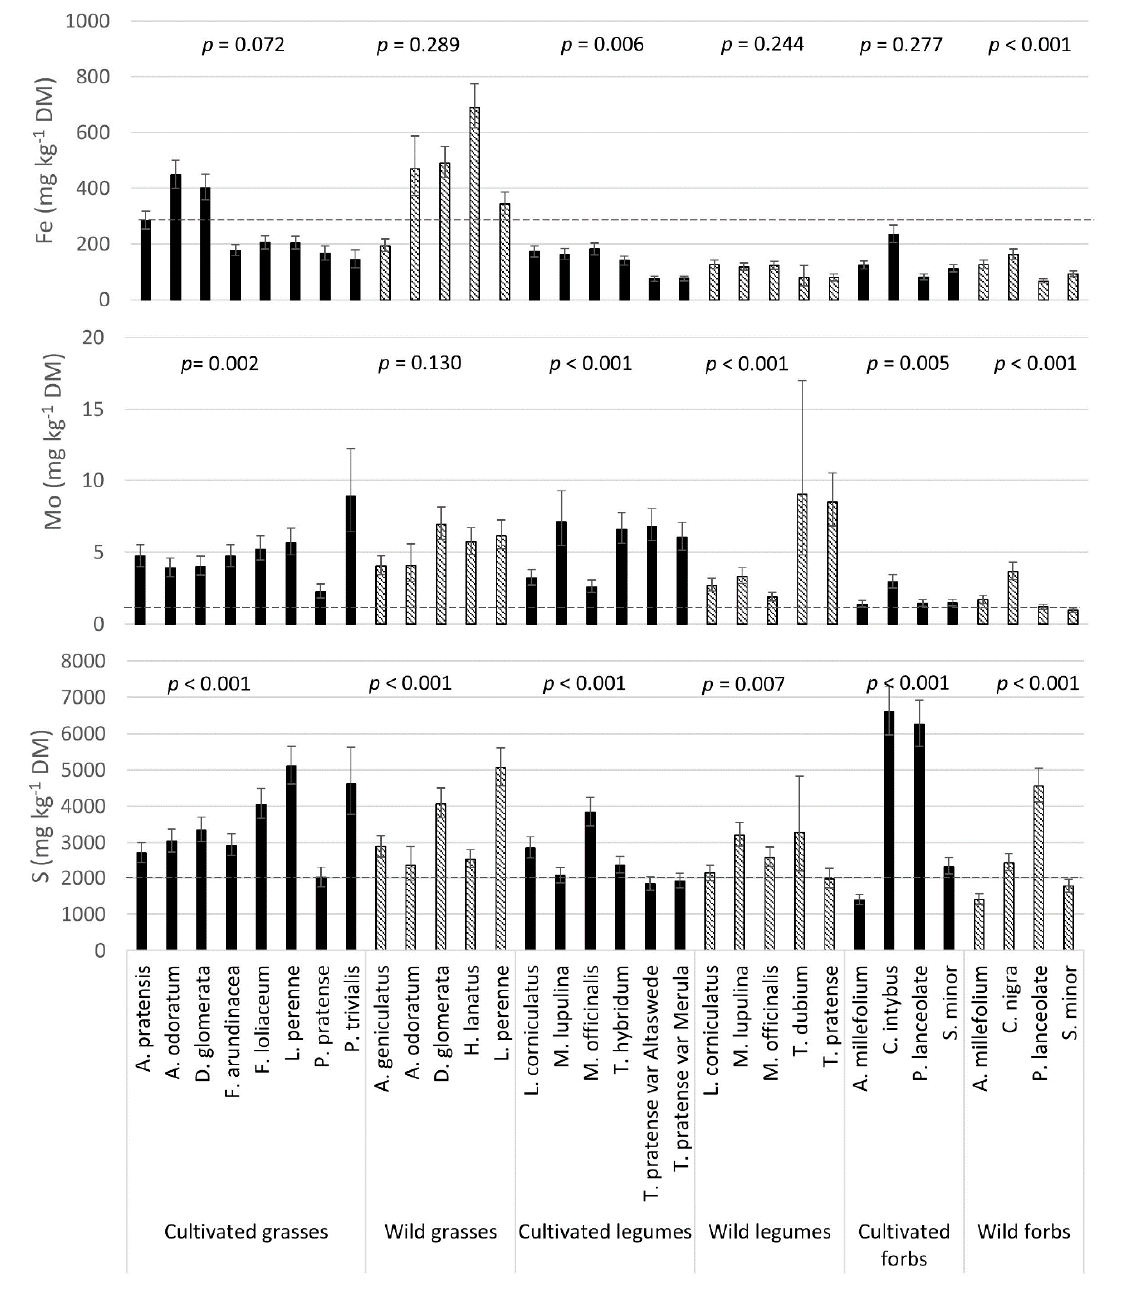
Figure 3. Barchart of means and confidence intervals of Mo, Fe and S in pasture species. Error bars show the confidence interval over the five replicates, as given by the LMM analysis. The p -value shows the significance of the di ff erence between species, within a plant type and botanical group. Dashed lines ( ꟷ ) indicate the maximum advised level in pasture to avoid deficiency of Cu (AHDB, 2011).